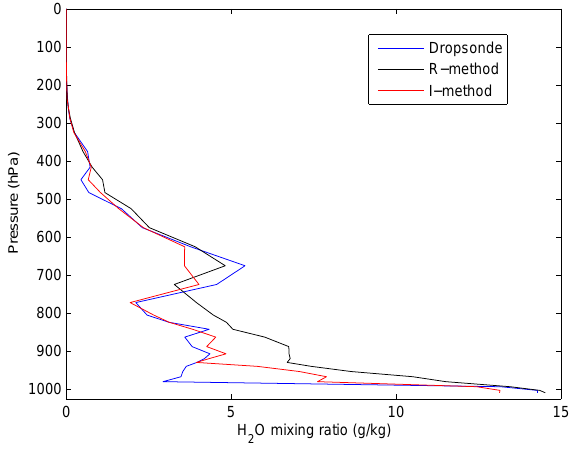
Figure 11. Results for the JAIVEx case study and for the case ( N = 300 , x Day 29 April 2007. The figure shows the mean retrieved profile for H approaches and their comparison with the dropsonde observation. The retrieved profile has been averaged over the six available IASI